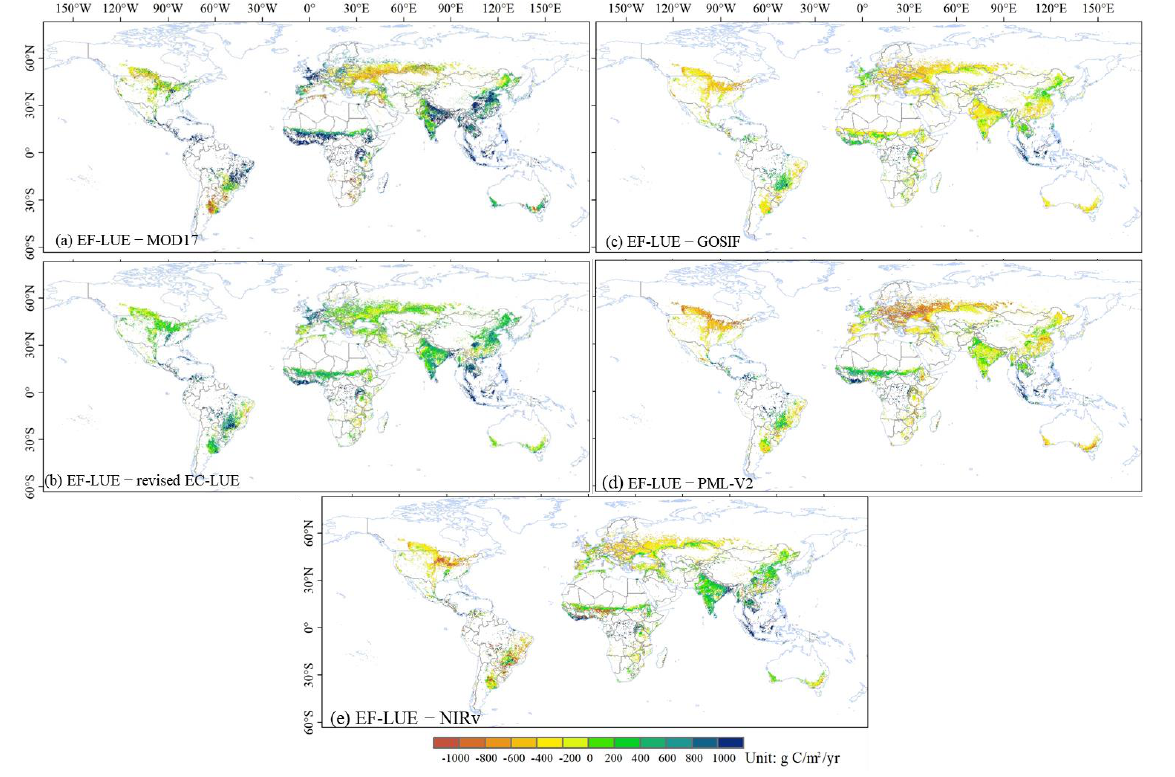
Figure 8. Mean annual GPP (in 2002–2018) difference between the EF-LUE model and ( a ) MOD17; ( b ) revised EC-LUE; ( c ) GOSIF GPP; ( d ) PML-V2; ( e ) NIRv GPP.